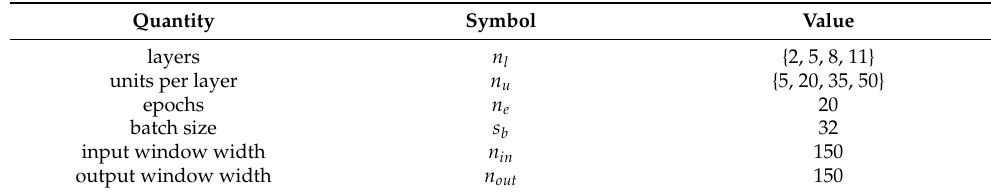
Table 5. Grid search settings for the spatial sensor data split.